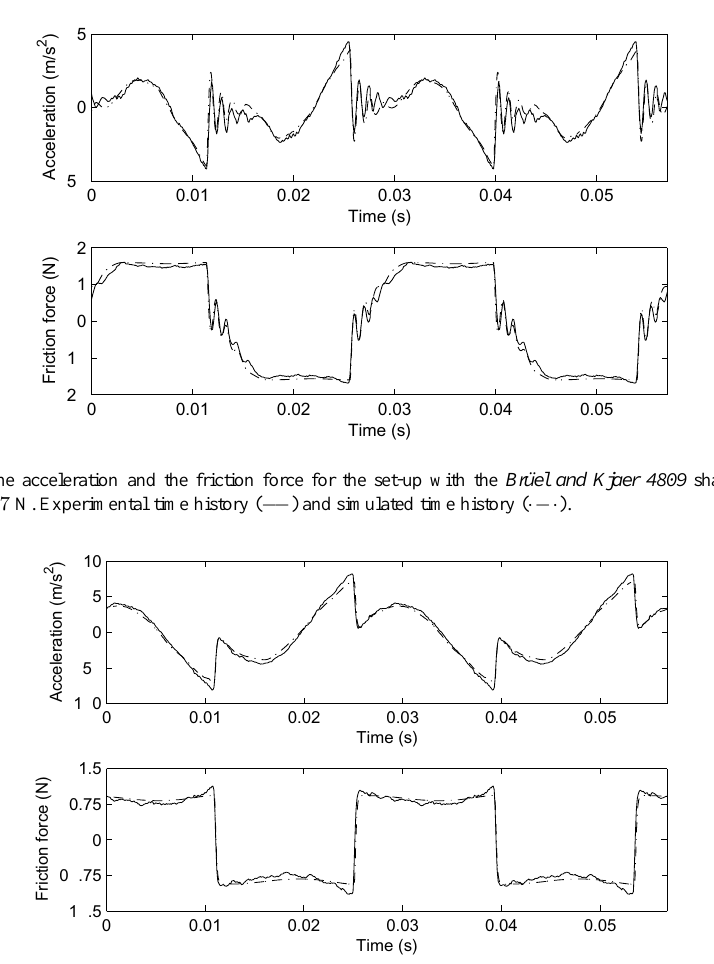
Fig. 13. Time history of the acceleration and the friction force for the set-up with the Br ¨ uel and Kjaer 4809 shaker with F ex = 1 . 75 N, ω = 35 Hz and γ N = 0 . 760 N. Experimental time history ( −− ) and simulated time history ( ·−·